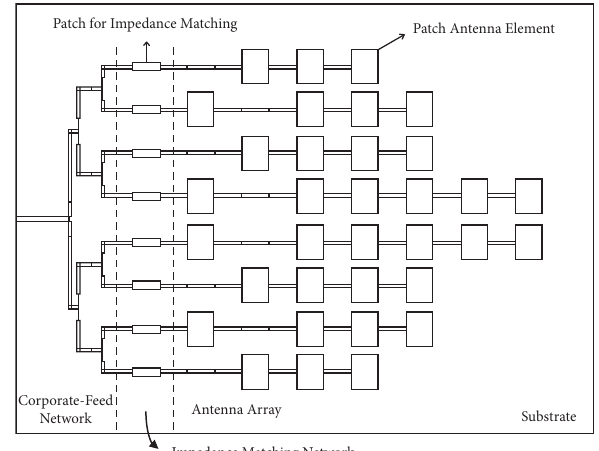
Figure 7: Proposed 34 elements thinned array antenna